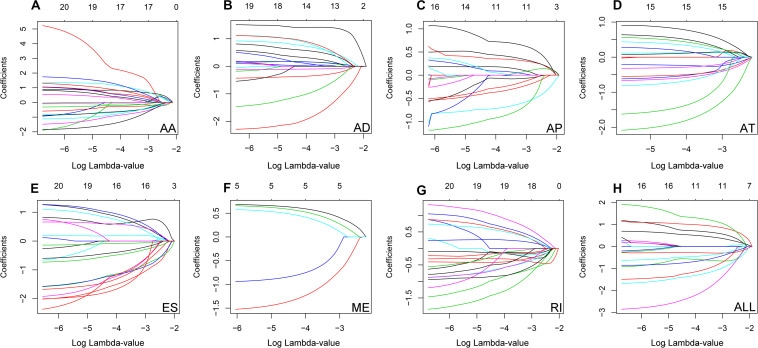
Candidate AS events was filtrated based on LASSO regression analysis.